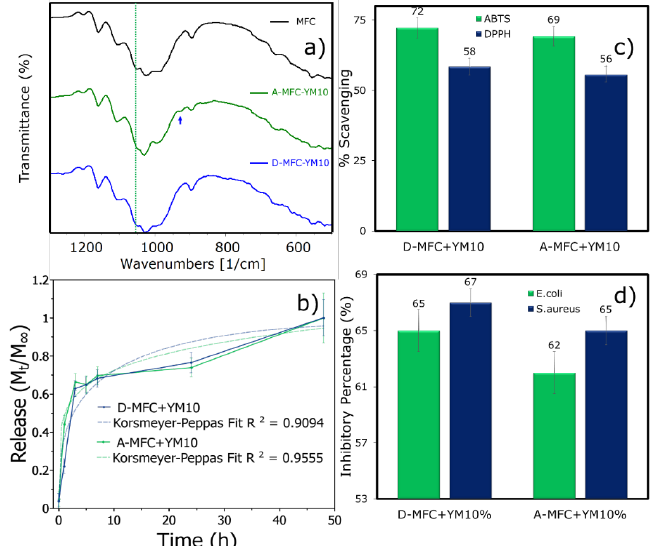
Figure 1. Studied samples for microfibrillated cellulose (MFC) films containing yerba mate extract blended during (D) the defibrillation process and after (A), ( a ) FTIR spectra, where dashed lines indicate the most important region and the arrow is an increased peak found after the extract is blended. ( b ) YM extract release and best-fit using Korsmeyer−Peppas, ( c ) ABTS and DPPH antioxidant scavenging activity and ( d ) bacteria growth inhibition of 25 mg samples containing yerba mate extract.